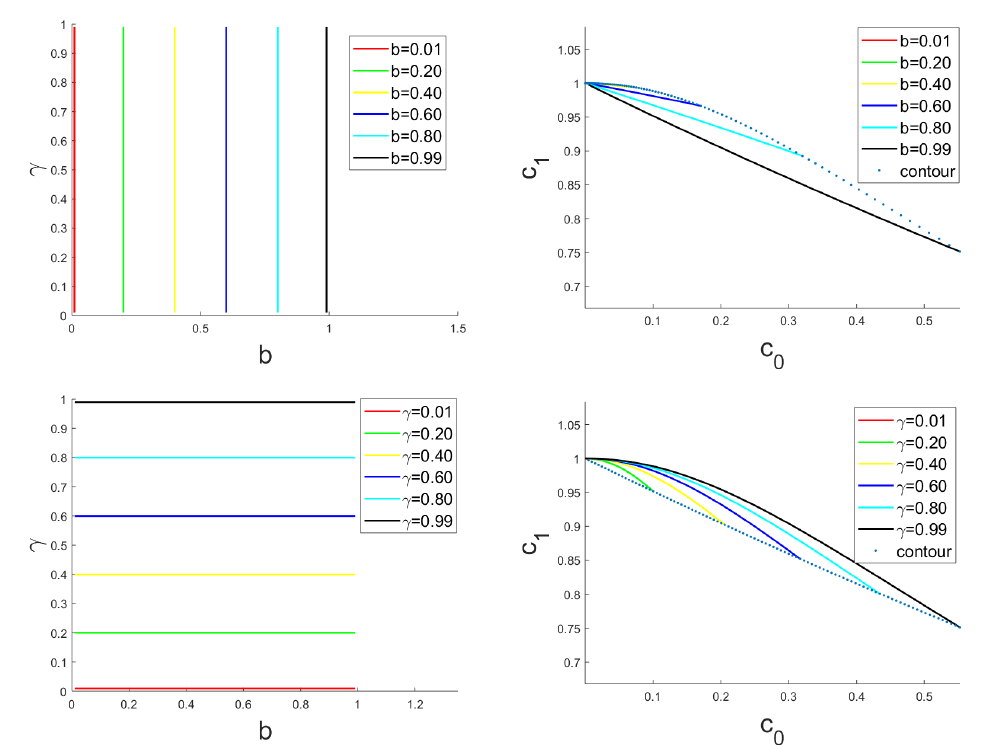
Figure 5. Coordinate lines of the map Λ h defined in (27) ( h = 10 − 2 ) . The upper figure contains the coordinate lines associated with b constant, while the lower one corresponds to γ